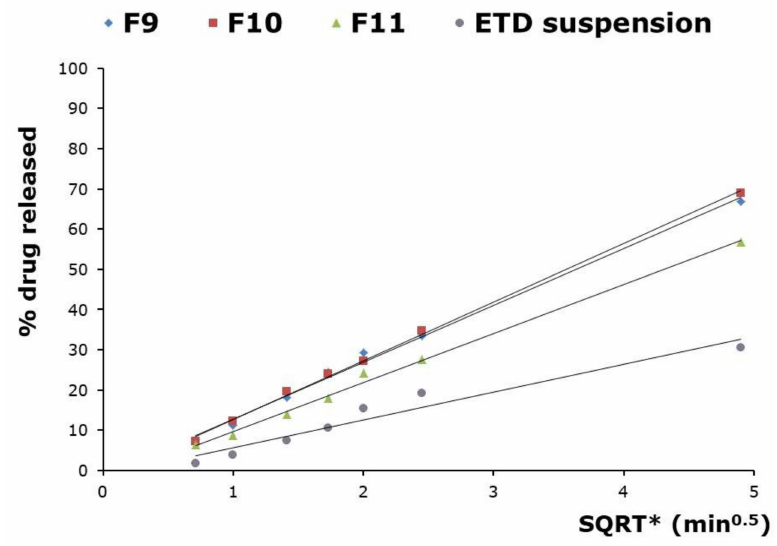
Figure 4. Higuchi diffusion model for the in vitro ETD release from NLC formulations in acetate